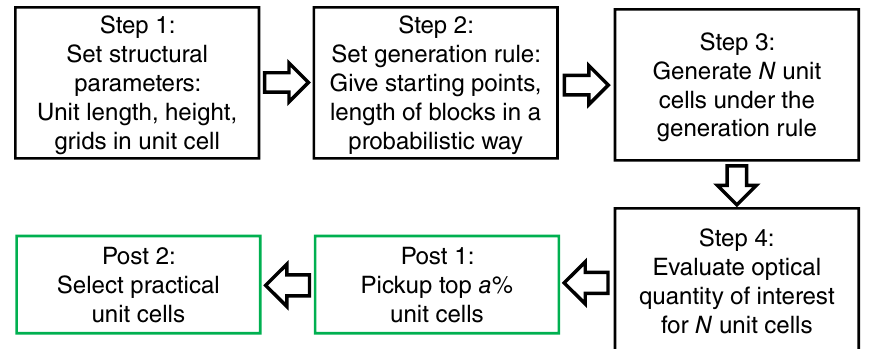
Figure 1. A sequence of procedures for the non-empirical structural search in this study. The structural search processes are indicated with black boxes, and post processes are indicated with green